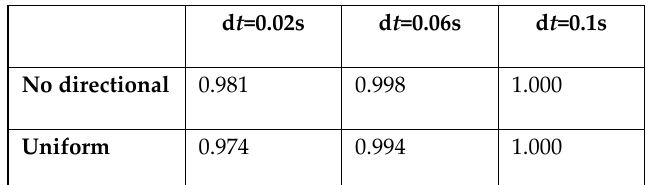
Table 3: Sensitivity of normalized mean power (-) influenced by the timestep for kPTO of 30 kN/m and cPTO of 500 KNs/m for the non-directional and uniform